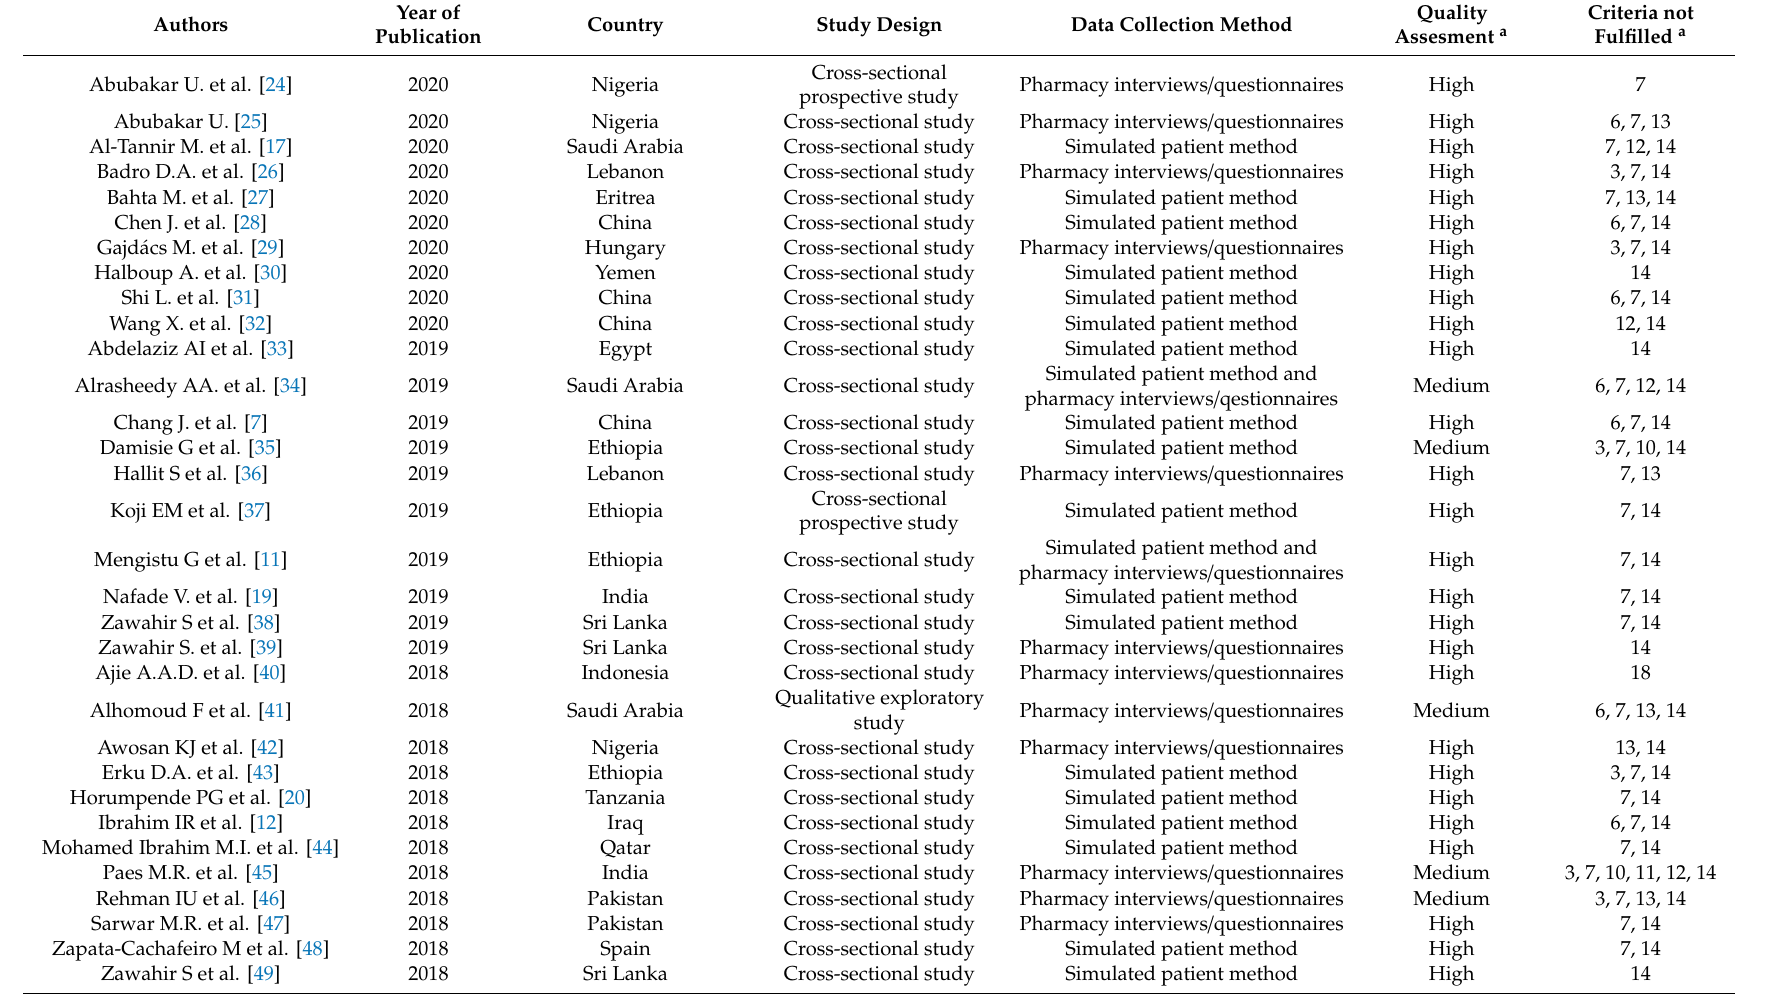
Table 1. Characteristics of the selected